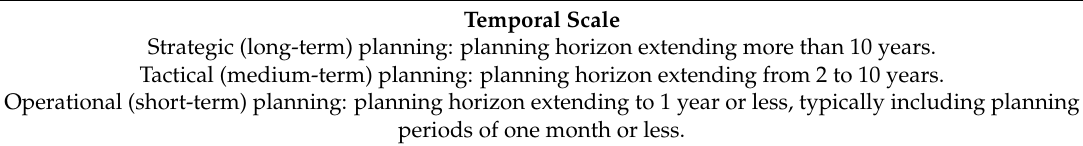
Table 2. Forest management problem type dimensions, based on Eriksson et al .